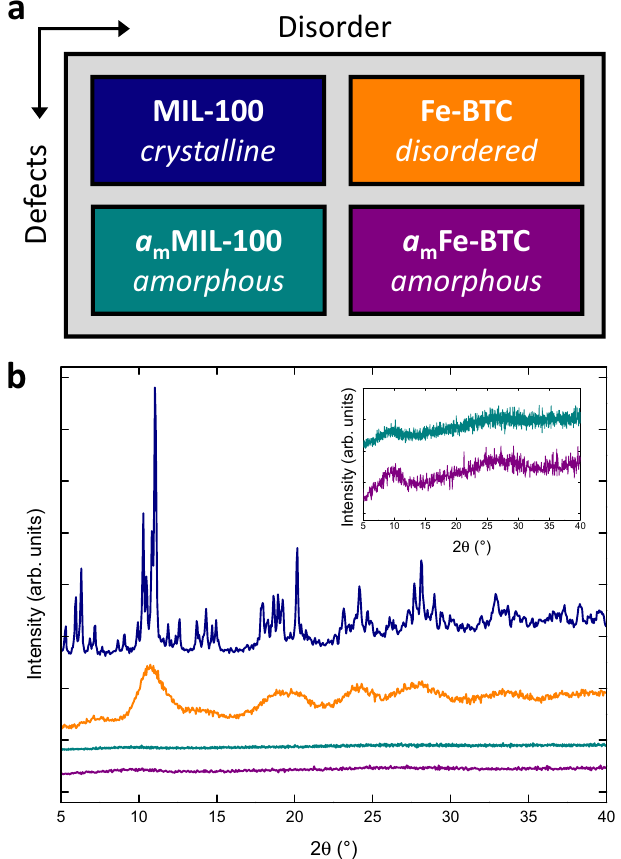
Fig. 2 Structural characterisation. a Diagram relating the four materials of interest. b Powder X-ray diffraction data for MIL-100 (navy), Fe-BTC (orange), a m MIL-100 (turquoise) and a m Fe-BTC (purple). Inset shows both amorphous materials. Data for MIL-100, Fe-BTC and a m MIL-100 reproduced from Refs. 13,35 . Data offset for